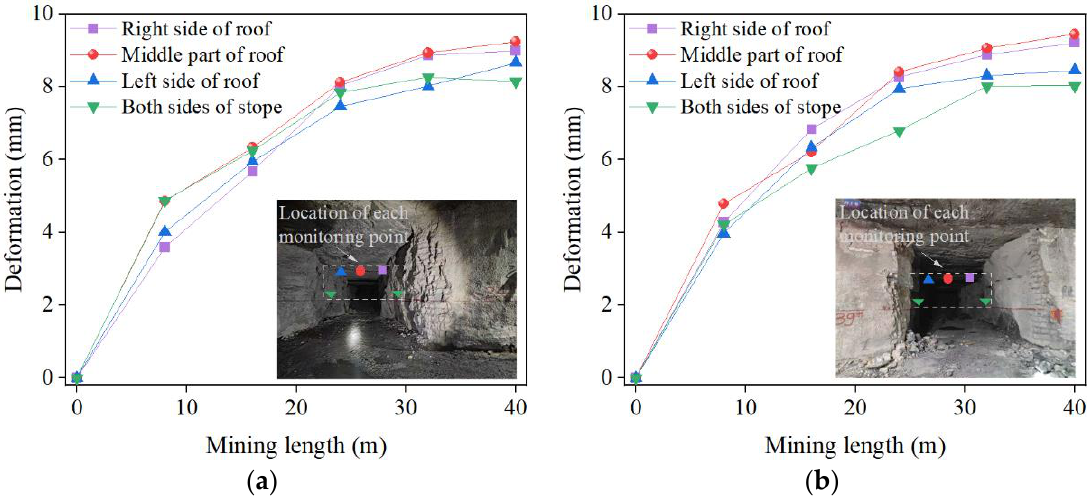
Figure 9. Comparison of calculation and measurement values: ( a ) load, ( b ) stress.